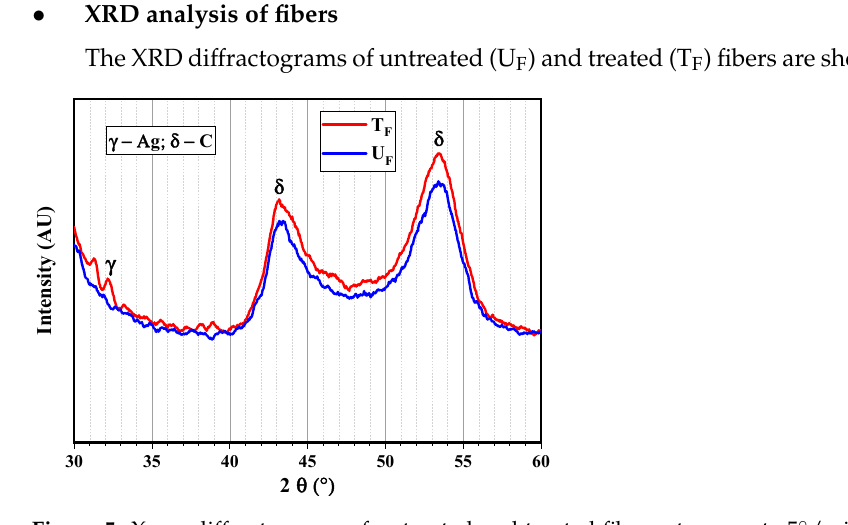
Figure 5. X-ray diffractograms of untreated and treated fibers at scan rate 5°/min for 2 θ varying from 10 to 80°.